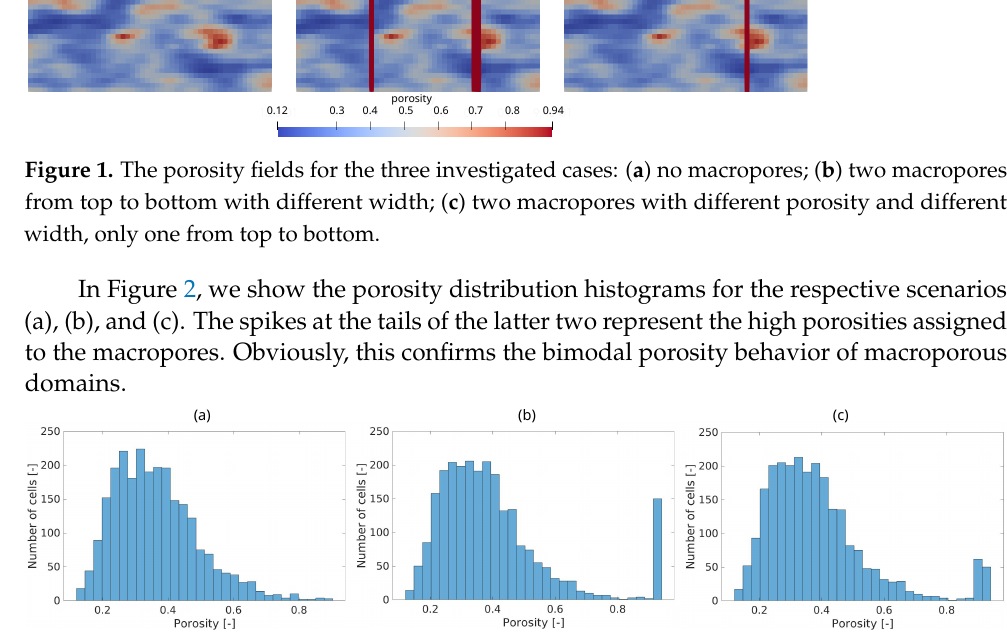
Figure 2. Porosity histograms for Scenarios (a–c). Every column depicts the number of cells for a porosity range [ φ min , φ max ) with ∆ φ = 0.0275 . The total number of cells is